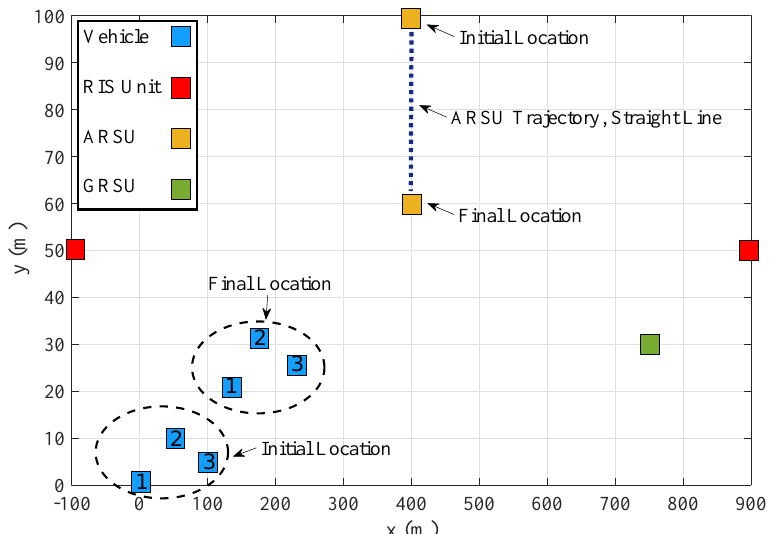
Figure 2. The projection of the proposed IoV architecture on the xy plane with pre-determined benchmark trajectories of three vehicles and the aerial road side unit